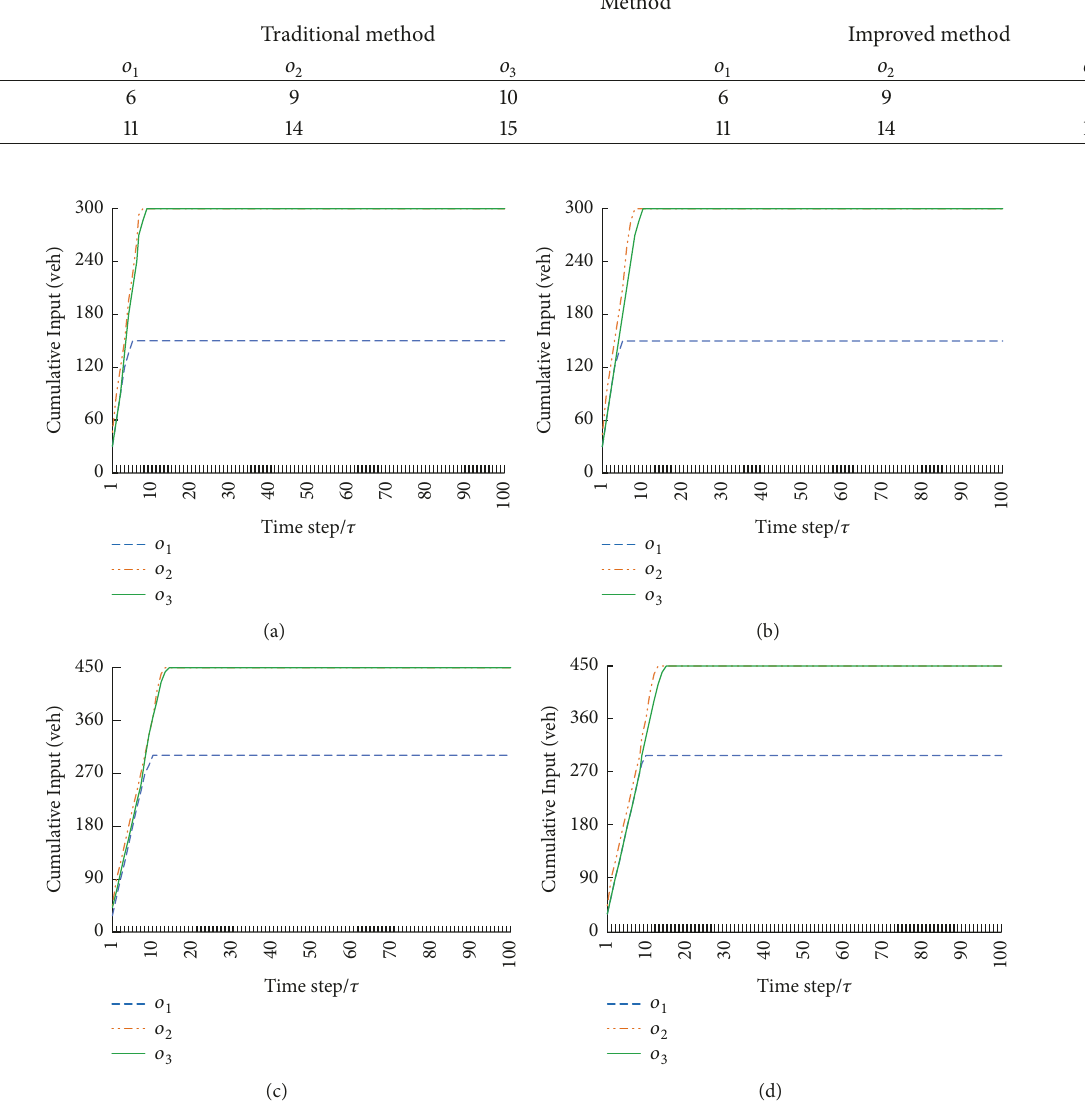
Figure 4: Cumulative evacuated persons of all residential communities under various evacuation situation: (a) traditional method, low demand; (b) improved method, low demand; (c) traditional method, high demand; (d) improved method, high